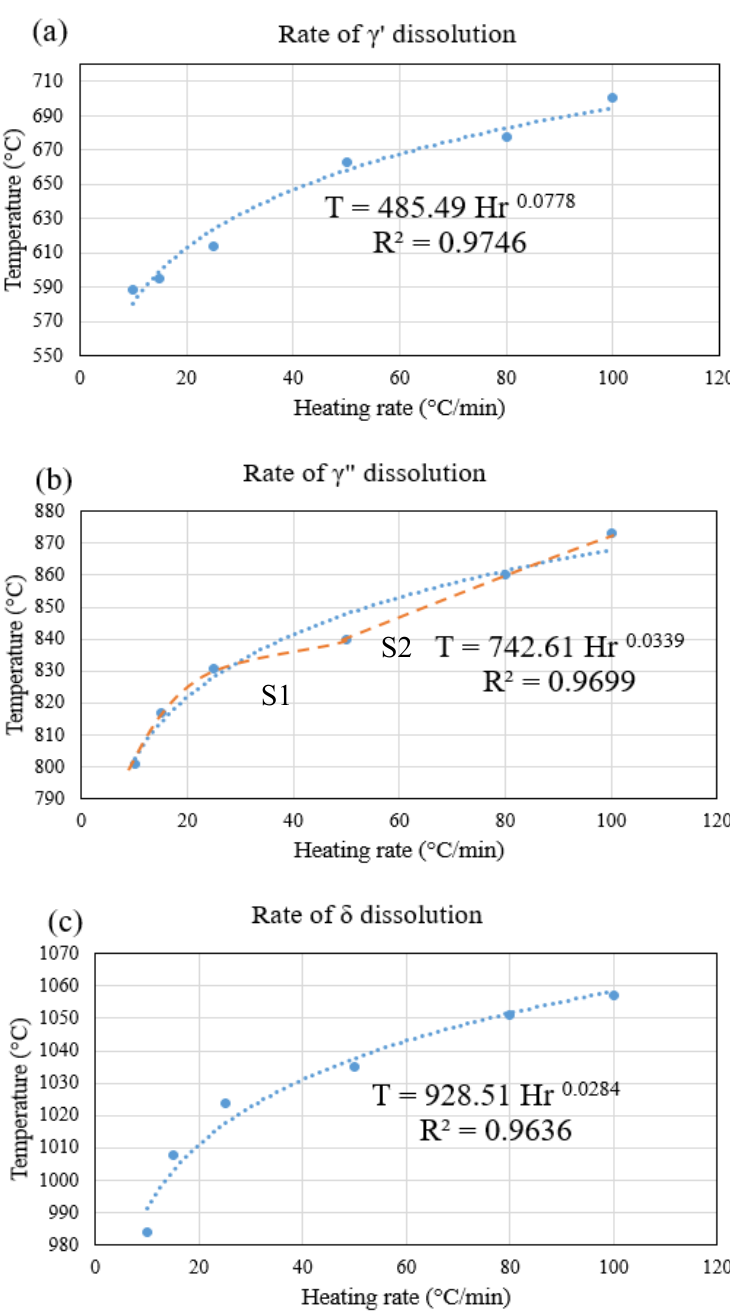
Figure 9. Variations of: ( a ) γ (cid:48) , ( b ) γ ”, and ( c ) δ phase dissolution temperature (T) with heating rate (Hr) at the top section of the SLM IN718